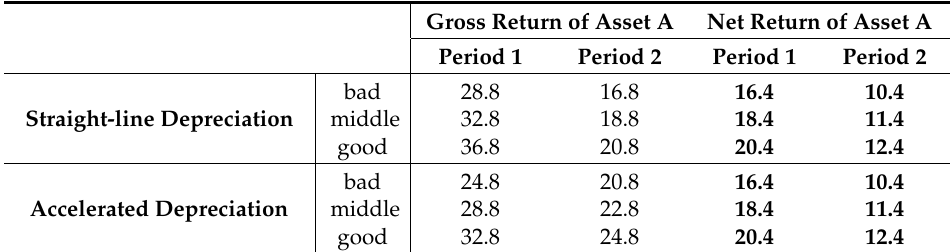
Table 5. Example for net value equivalence decision situations (i.e., all net payoffs are identical across the treatments with straight-line and accelerated depreciation; used to test Hypothesis 2).